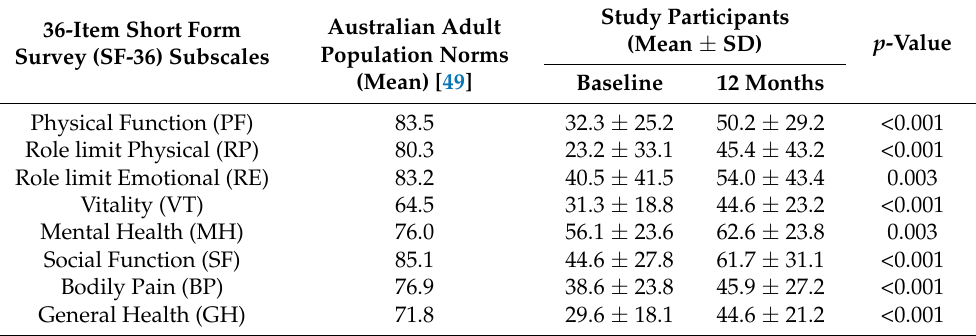
Table 3. SF-36 subscale scores of study participants at baseline and 12 months, with p -values, compared with the Australian adult population